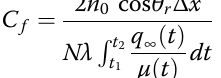
λϕ 1 ffiffiffiffiffiffiffiffiffiffiffiffiffiffiffiffiffiffiffiffiffi h ¼ o 4 π − sin 2 θ n 2 i 0 where ϕ is the phase difference between the portion of the beam reflected from the top of the oil and that transmitted through the oil, n is the index of reflection 0 of oil, and θ i is local illumination angle. Then, the skin friction can be determined by Eq. (4) according to the solution of Eq. (2) and Eq. (3).